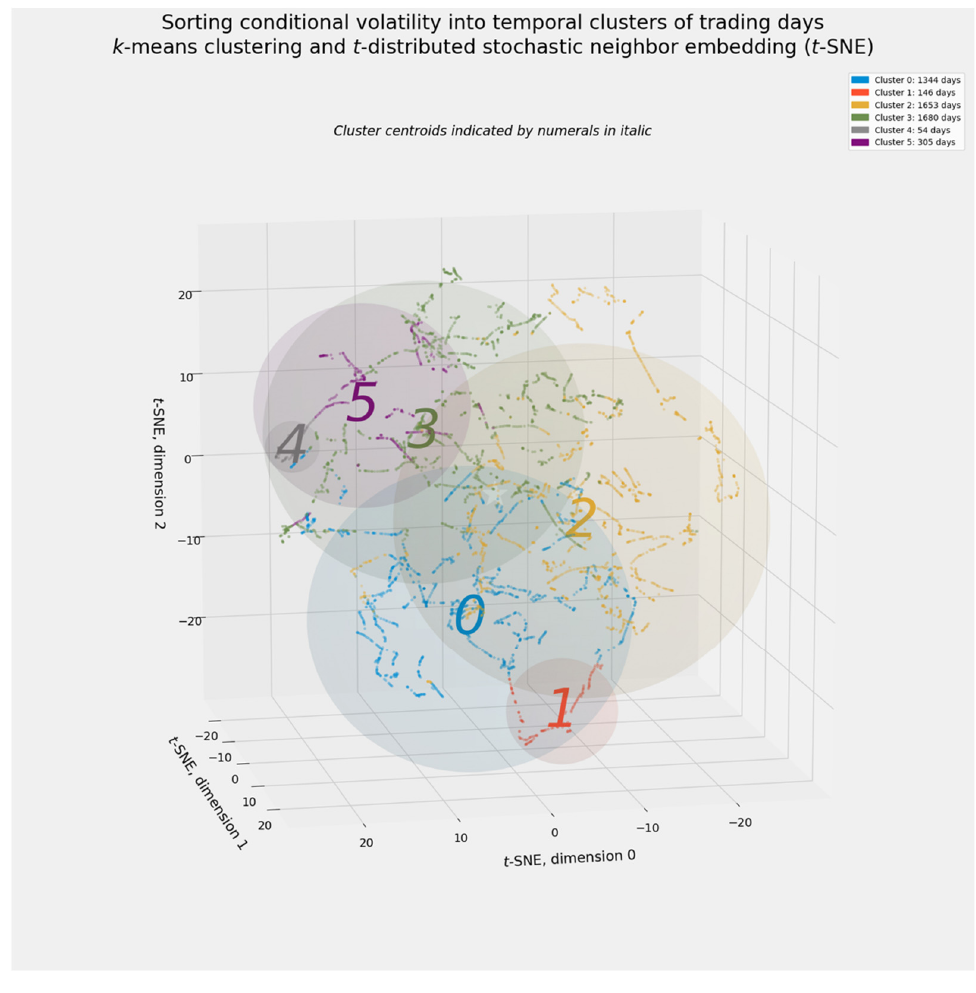
Figure 15. k -means clustering of commodity markets—A t -SNE manifold. Like mean-shift clustering, k -means clustering relies on the stochastic instantiation of centroids. k -means clustering, however, generates the least contiguous and the least visibly cogent set of clusters. Figure 16 reveals only two wholly contiguous clusters (1 and 4), which coincide with the financial crisis and the pandemic.